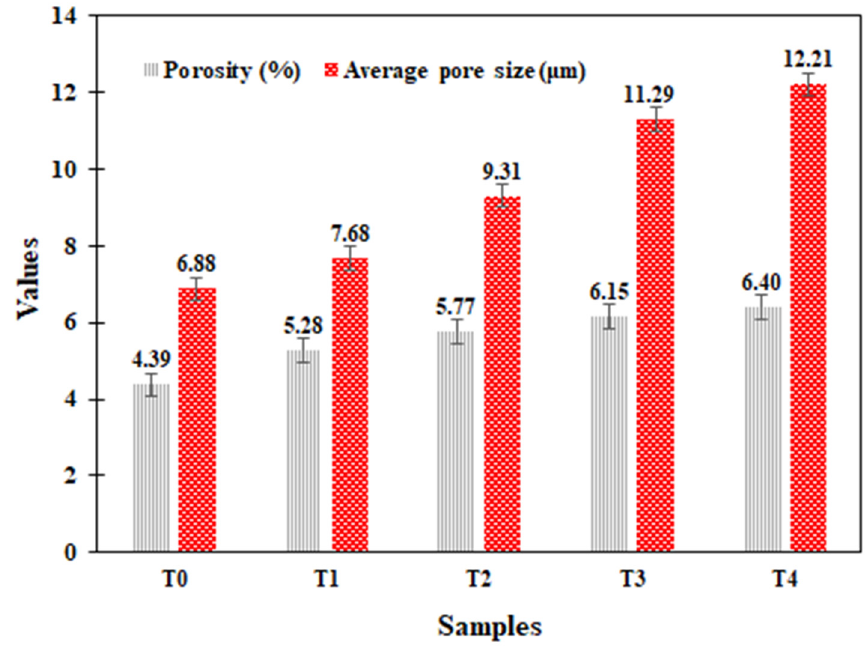
Figure 3. The average percentage of porosity and the average size of porosity with increasing con- centration of TiO 2 NPs.